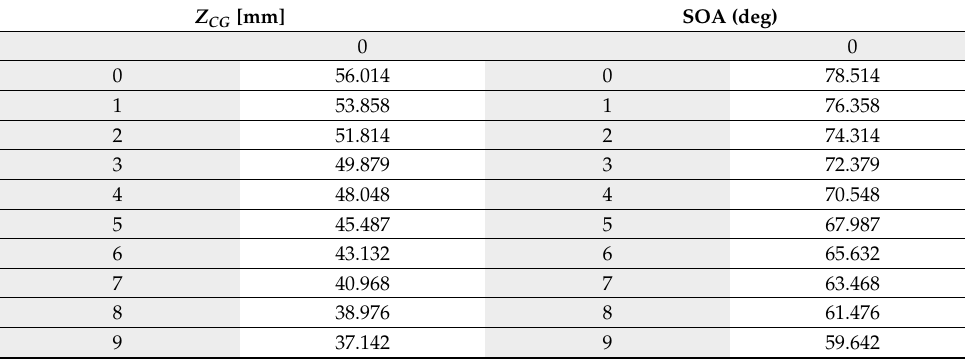
Figure 10. Combine harvester technical data. Table 4. SOA angle calculated on the basis of the ZCG values for combine